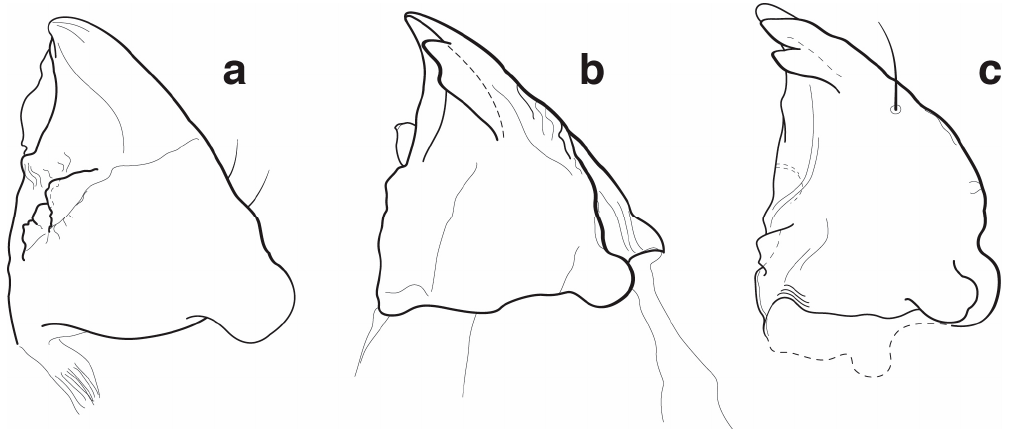
Figure 35. Mandible, larva: ( a ) Eucalandra ; ( b ) Nassophasis ; and ( c ) Polytus .